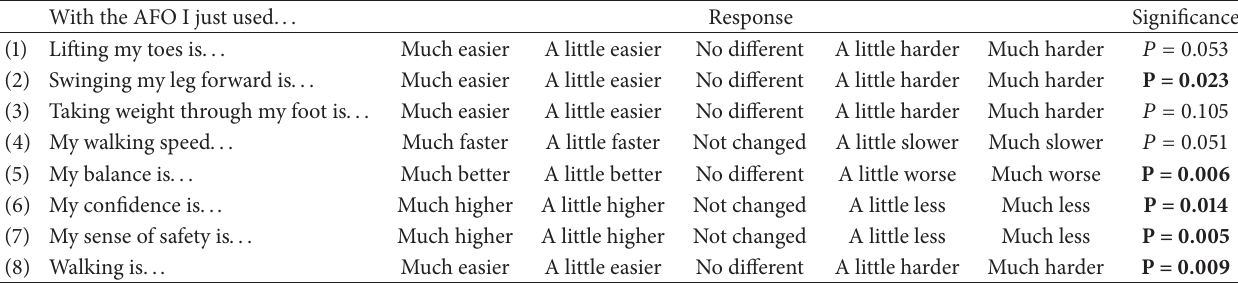
Table 1: Subjects perception of Functional Benefit Survey. With the AFO I just used ...